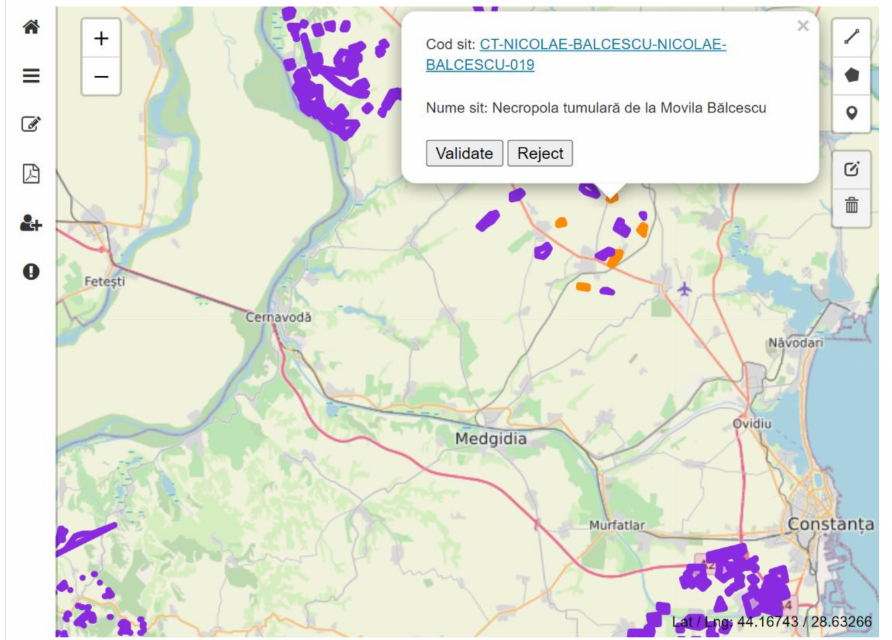
Figure 17. Archeological sites during the validation process (orange) viewed by the application manager and validated sites